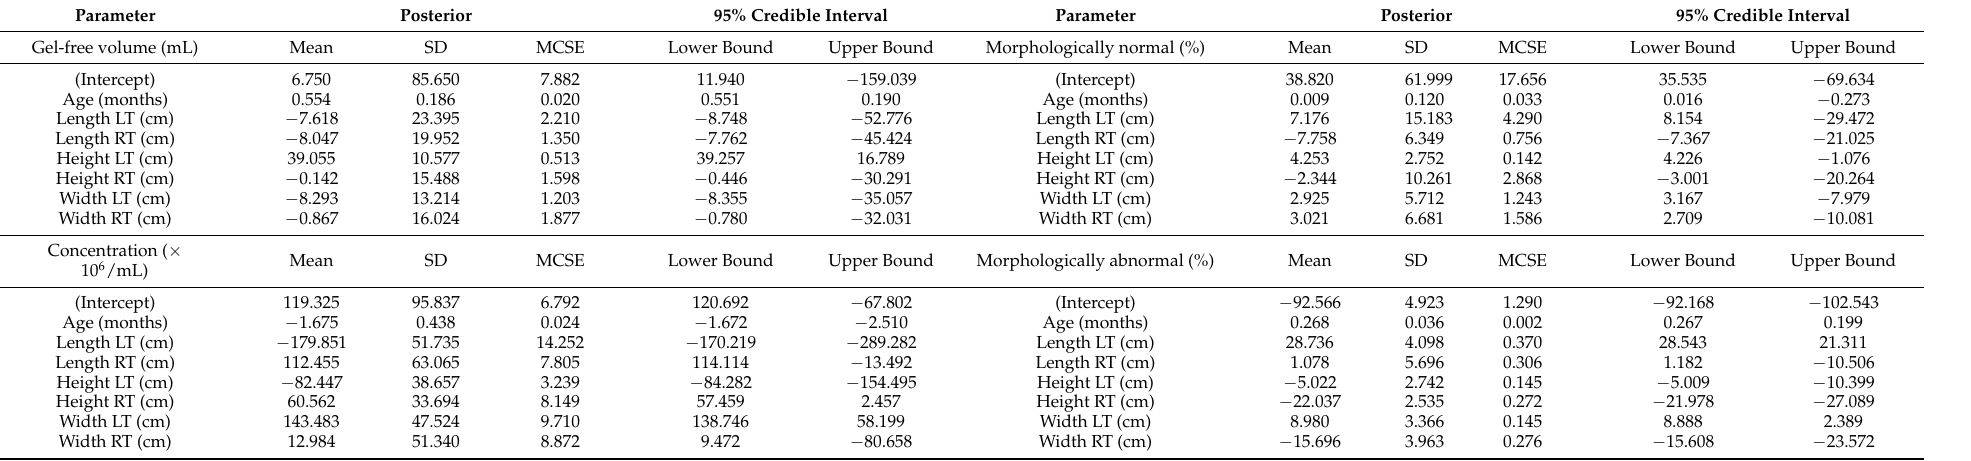
Table 5. Bayesian Estimates of Unstandardized Linear Regression Coefficients for predictive model 1 for gel-free volume (mL), concentration ( × 10 6 /mL), morphologically normal (%), and morphologically abnormal (%) sperm output in Miranda donkey breed.